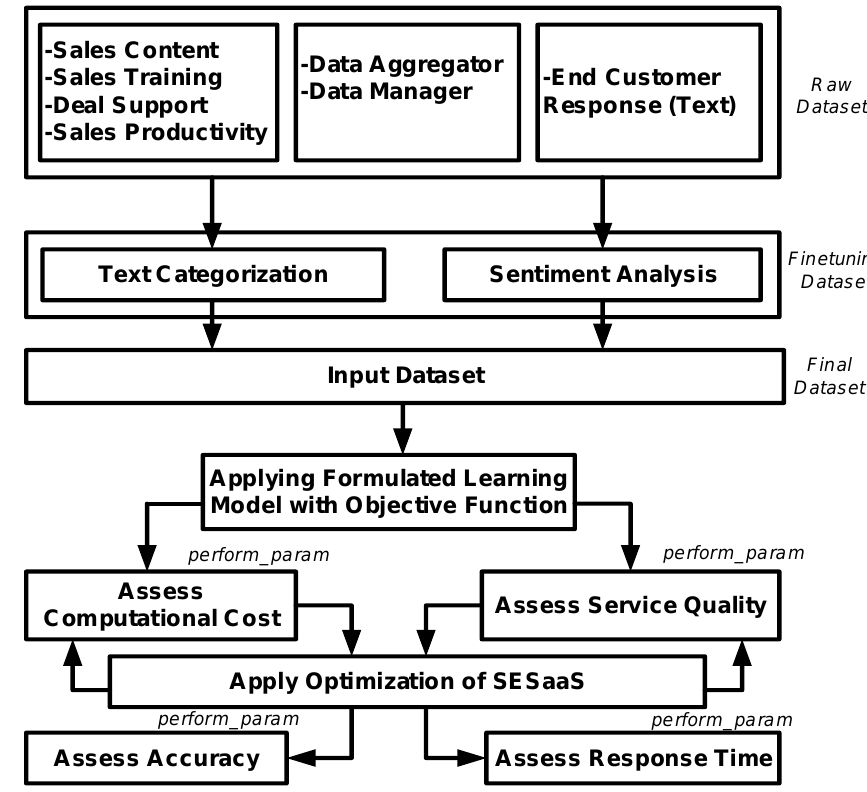
Figure 5. Implementation flow for the proposed scheme.